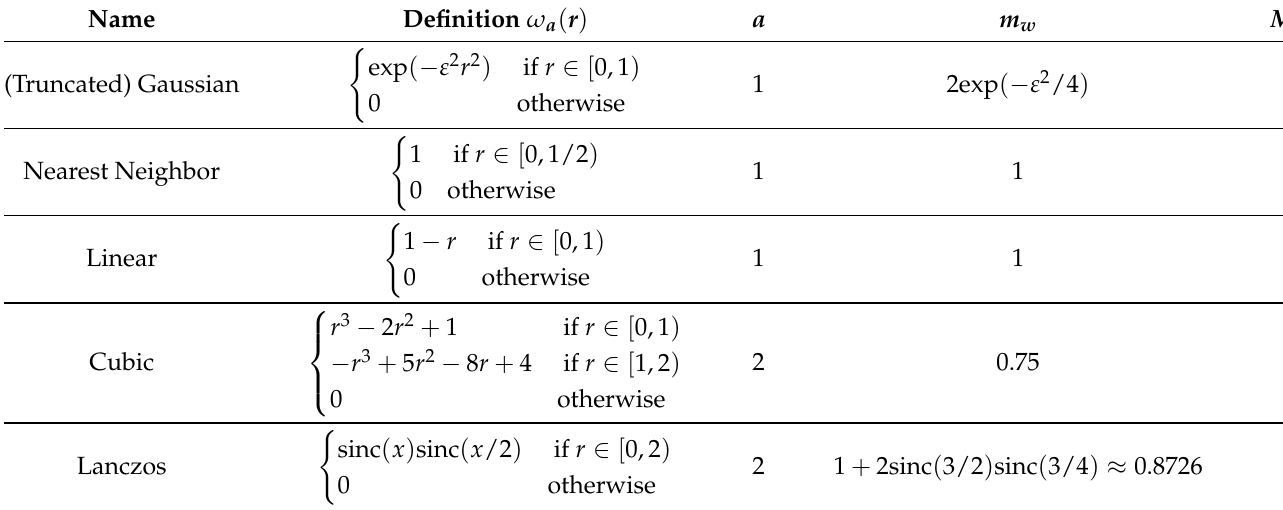
Table 1. Name and definition of the basis functions ω a used in imaging and neuroimaging, along with the support radius a and the constants m ω and M ω . The shape parameter for the Gaussian in this paper is chosen as ε = 2; in such case m w ≈ 0.736. As sinc function we mean the normalized sinc, defined as sinc ( x ) = sin ( π x ) / ( π x ) if x (cid:54) = 0; sinc ( 0 ) =